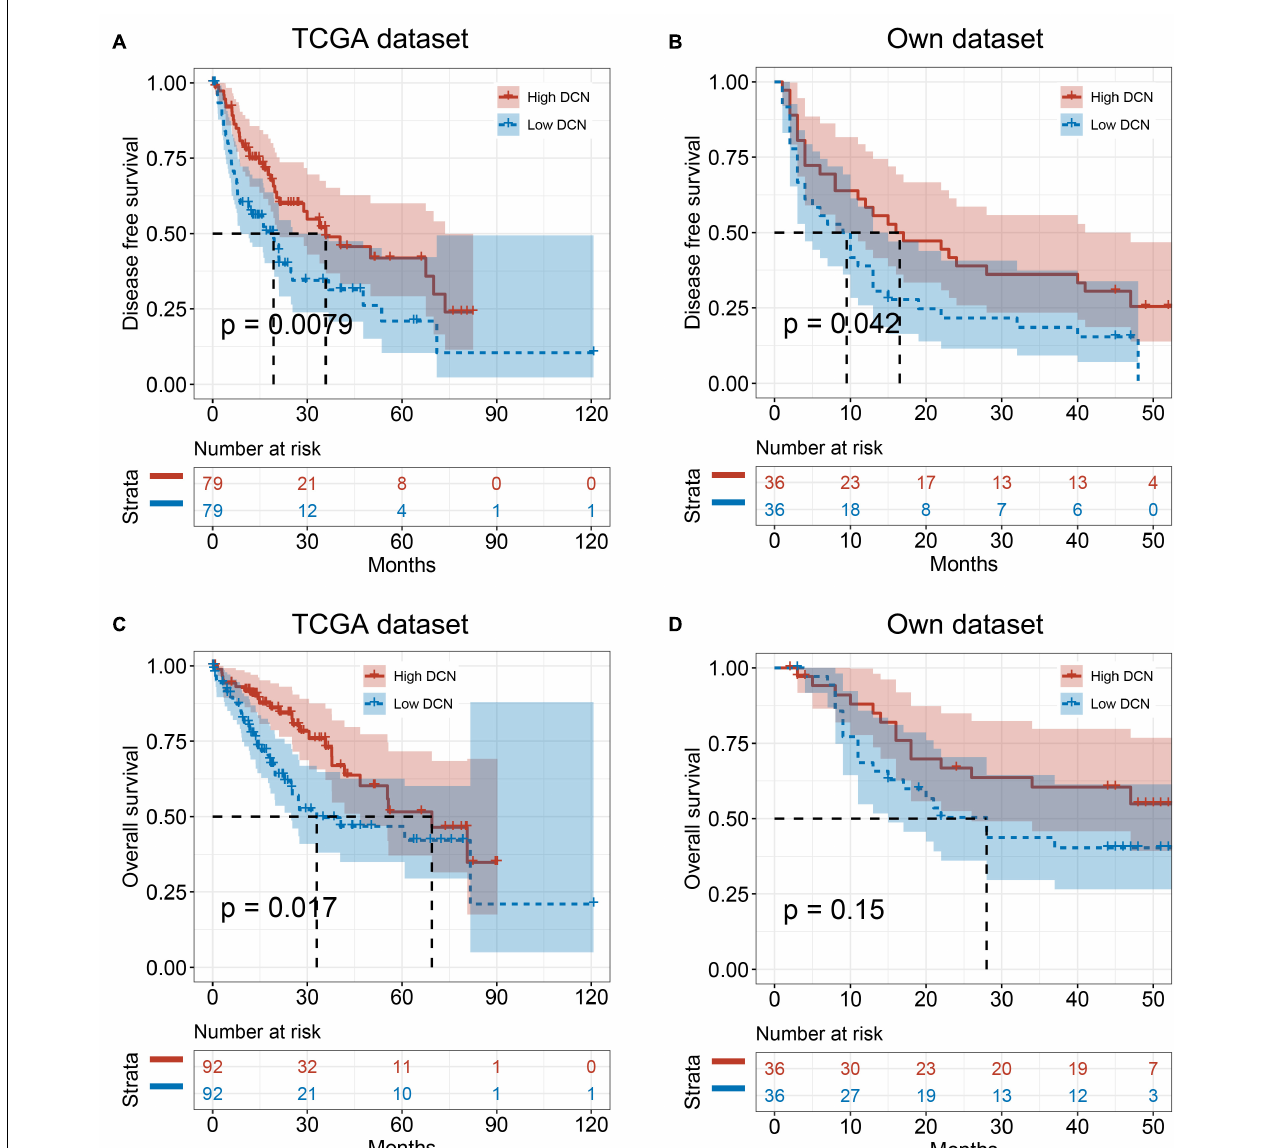
FIGURE 3 | Low DCN expression levels correlate with poor prognosis. (A,B) Kaplan–Meier analyses showing the correlations between DCN expression level and disease-free survival of patients with HCC from TCGA database (A) and our own dataset (B) . (C,D) Kaplan–Meier analyses of the correlations between DCN expression level and overall survival of patients with HCC from TCGA database (C) , and our own dataset (D) . The median expression level was used as the cut-off. Values are expressed as the median with interquartile range. TCGA, The Cancer Genome